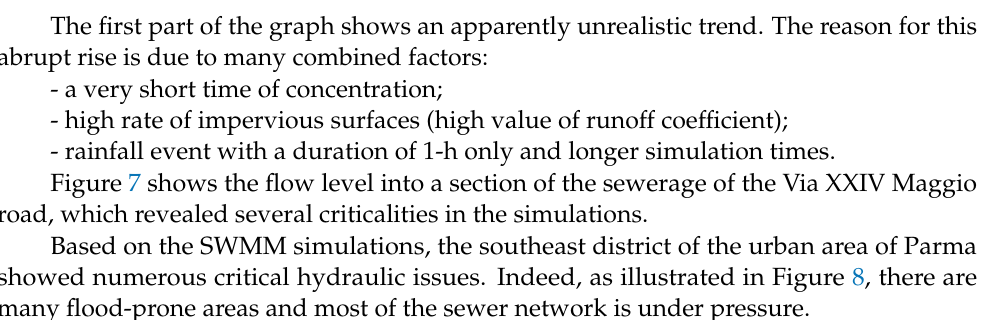
Figure 7. Water elevation profile at the peak moment, TR = 25 years, Via XXIV Maggio. Based on the SWMM simulations, the southeast district of the urban area of Parma showed numerous critical hydraulic issues. Indeed, as illustrated in Figure 8, there are many flood-prone areas and most of the sewer network is under pressure.